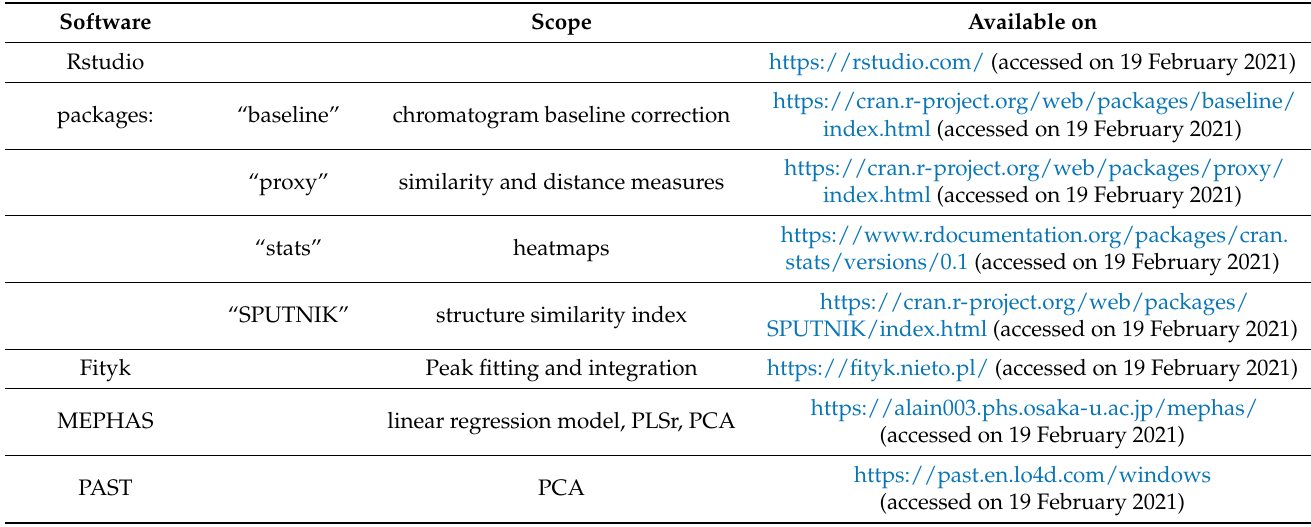
Figure 5. Flowchart of the analytical procedures for the assessment of CMS in formulations. Rstudio, Fityk, MEPHAS and PAST are the freely available software used. Table 7. The freely available software employed for the analysis of